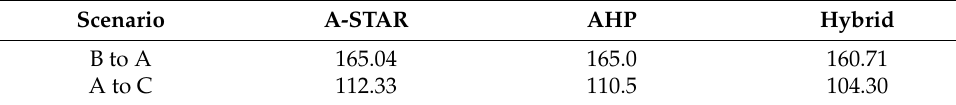
Table 4. Travel distance of path-planning methods.